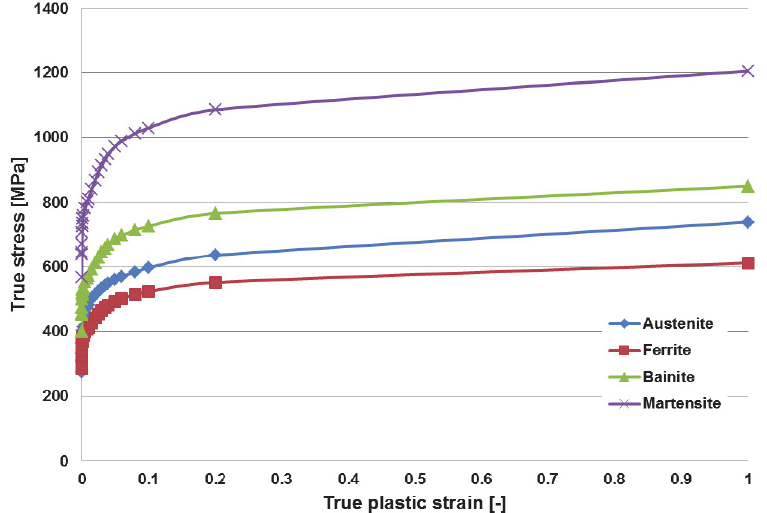
Figure 6: Strain hardening of phases for 15H2MFA.